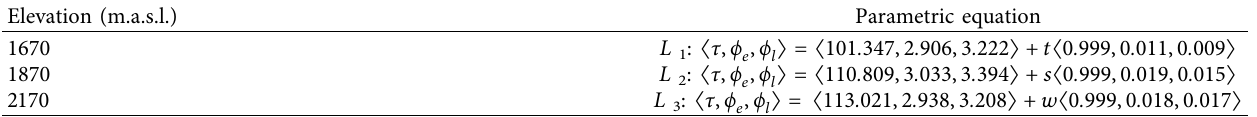
Table 3: Parametric equations of the 3D lines by elevation (m.a.s.l.: meters above sea level). Elevation (m.a.s.l.)